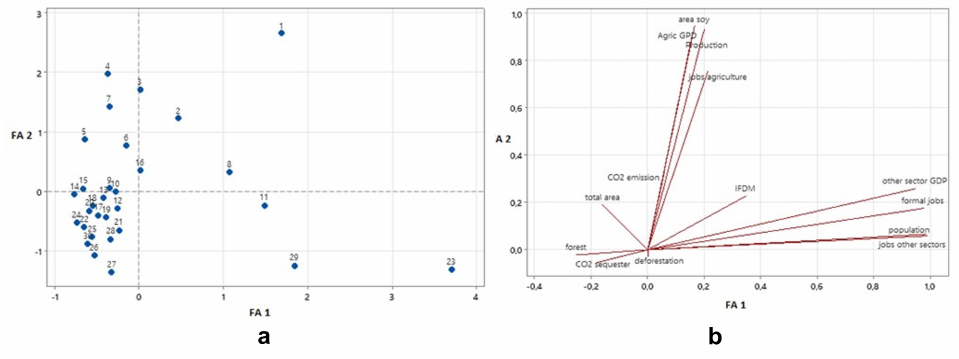
Figure 3. The factor analysis score plot (65.7% of cumulative variance) ( a ), and the factor analysis loading plot ( b